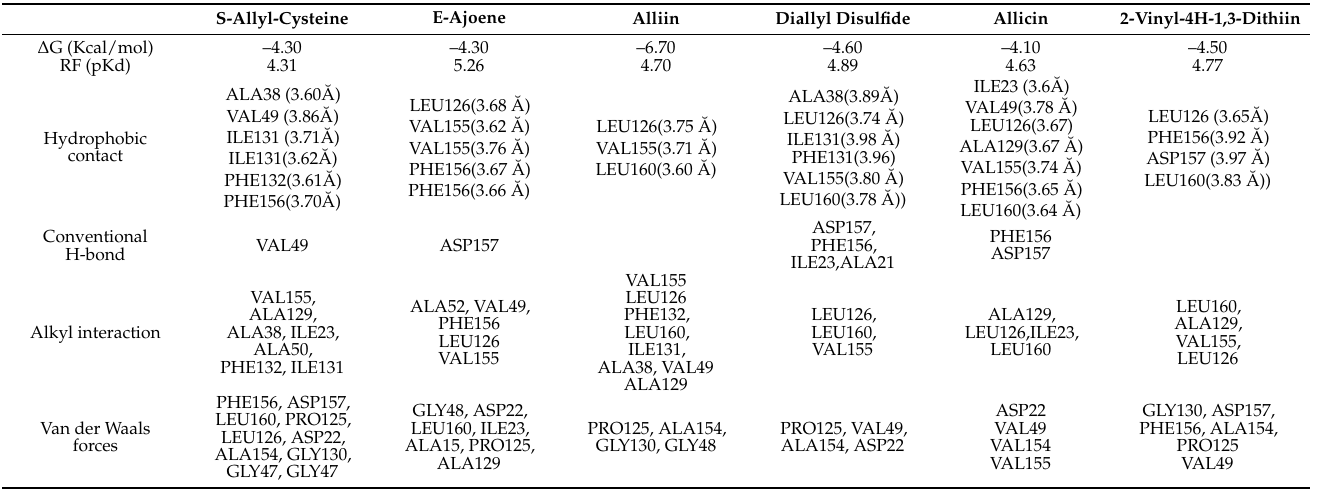
Figure 7. Blood − brain barrier permeation and in silico cytotoxic properties of some organosulfur compounds in garlic. ( A ) Blood − brain barrier penetration (BBB) permeation curve of some organosulfur compounds in A. sativum . The BBB permeation ability was measured by the support vector machine (SVM) and LiCABEDS algorithms of the BBB prediction server. ( B ) In silico cytotoxic properties of some organosulfur compounds in garlic against cancer cell lines. Pa = activity, pi = inactivity. Table 2. Docking profile of NSP3 (SH2D3C) with the organosulfur small molecule from Allium sativum . S-Allyl-Cysteine